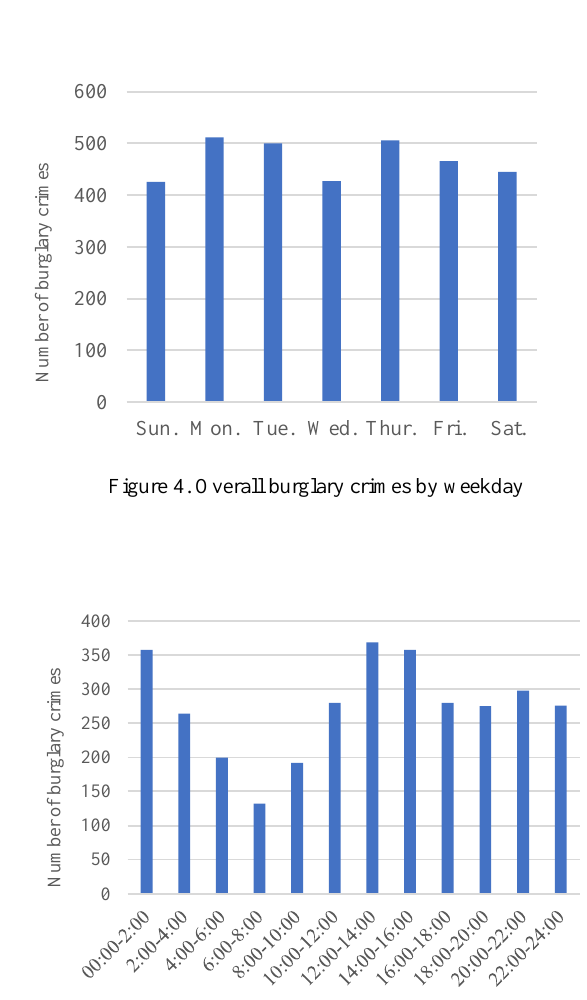
Figure 5. Overall burglary crimes by 2-hour interval in a day At the weekday temporal scale, Monday had the most burglary crimes followed by Tuesday and Thursday. Sunday and Wednesday had the least burglary crimes comparatively. Overall, within a day, burglary crimes concentrated from midnight to 2:00, 12:00 to 14:00 and 14:00 to16:00. 4:00 to 8:00, on the other hand, had the least burglary crimes between 2006 and 2016.